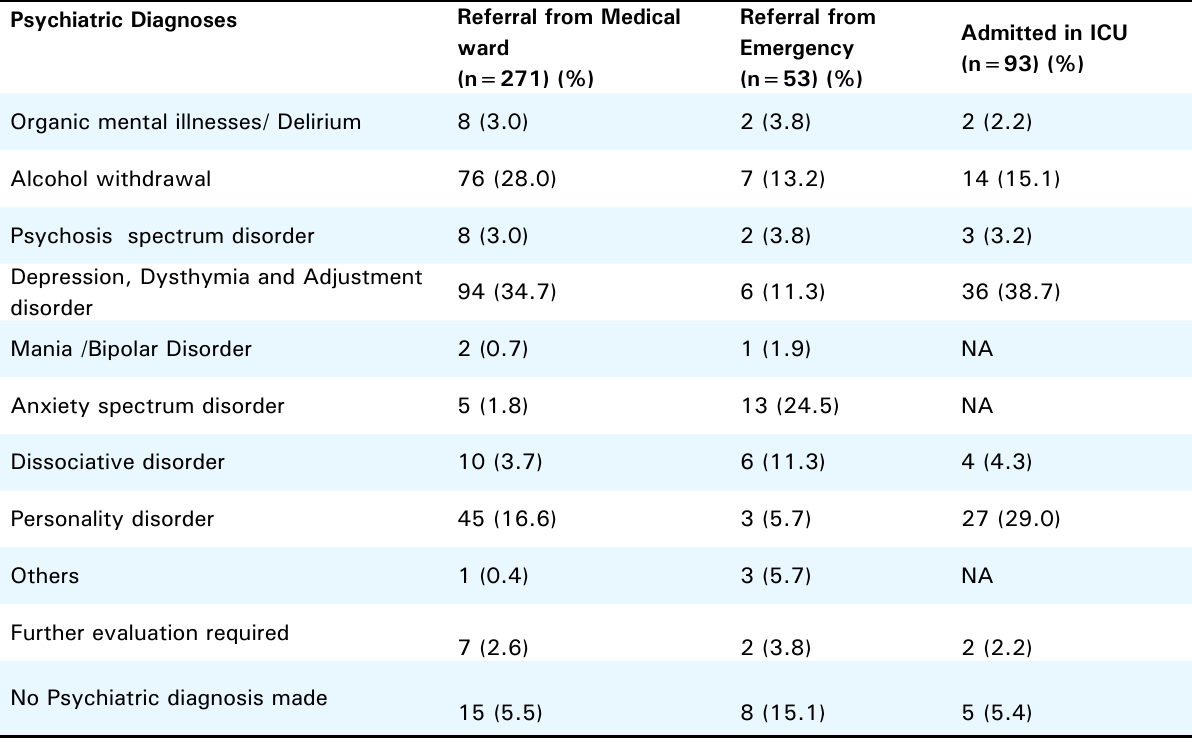
Table 6. Psychiatric Diagnosis among the Patients referred from Medical ward and Emergency and those admitted in